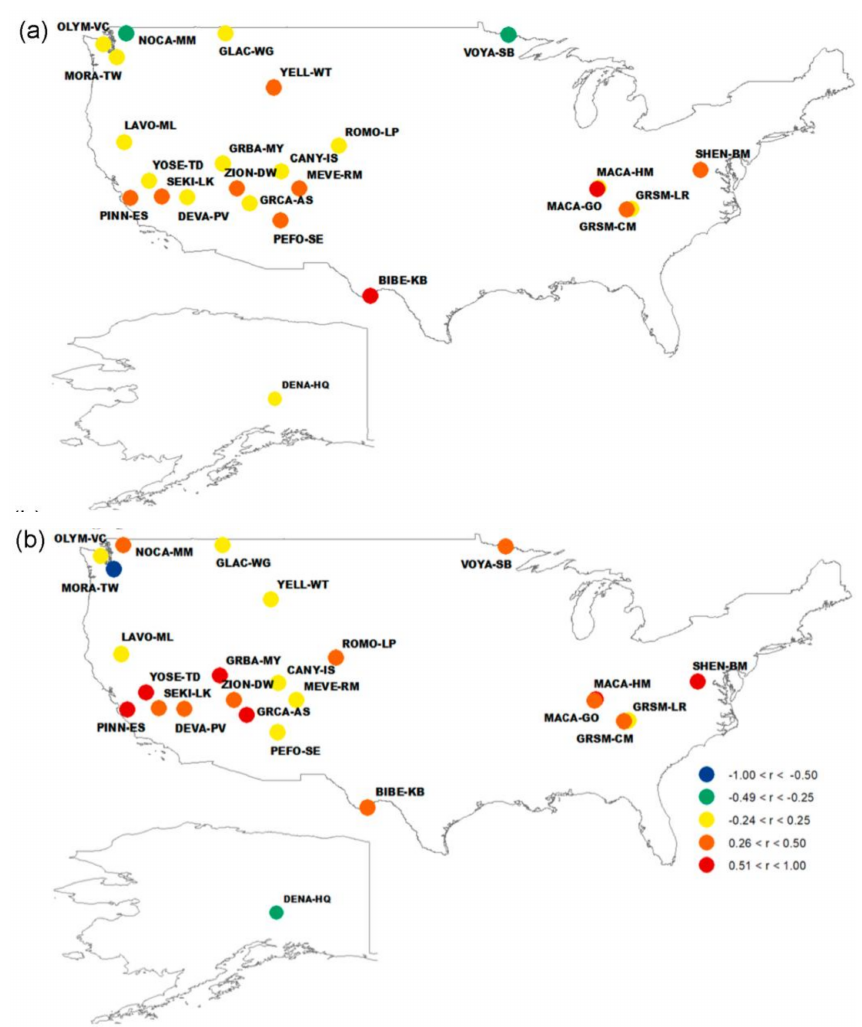
Figure 6. Spearman rank correlation coefficients between the C9 components for ozone and temperature ( a ), and the C10 components for ozone and temperature ( b ).